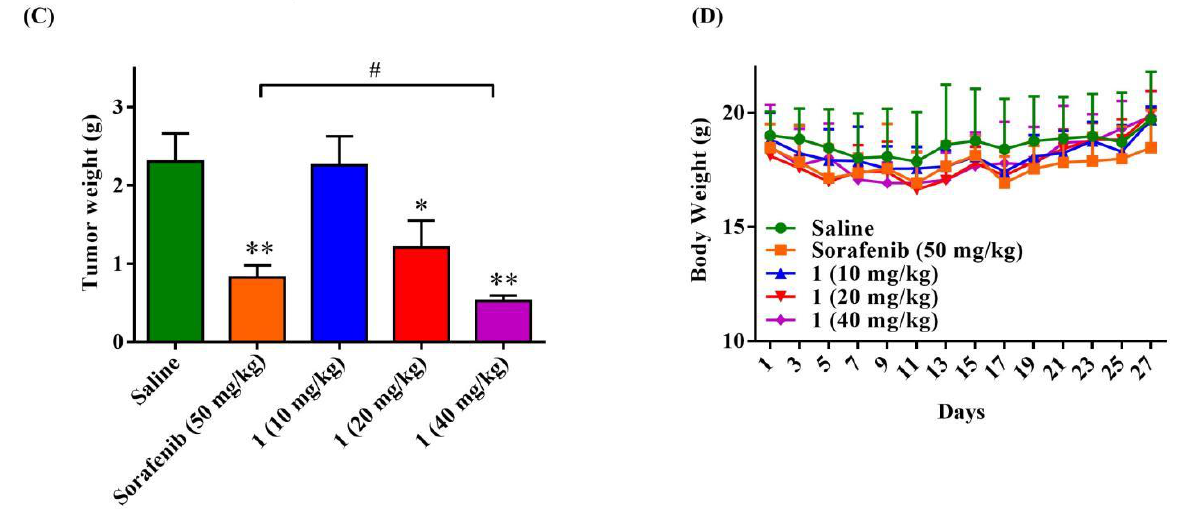
Figure 8. Compound 1 suppressed the tumor growth and metastasis in 4T1 mammary carcinoma model. Average tumor growth curves of each treatment group in 4T1 tumor-bearing mice ( A ). Tumor image ( B ) and tumor weight ( C ) of tumors excised from 4T1 tumor-bearing mice after treatment for 29 days. ( n = 10, means ± SEM are shown, * p < 0.05, ** p < 0.01, compared with Saline treatment group; # p < 0.05, compared with Sorafenib treatment group.) Curves showing the body weight change of mice under various treatments in 4T1 tumor-bearing mice ( D ).